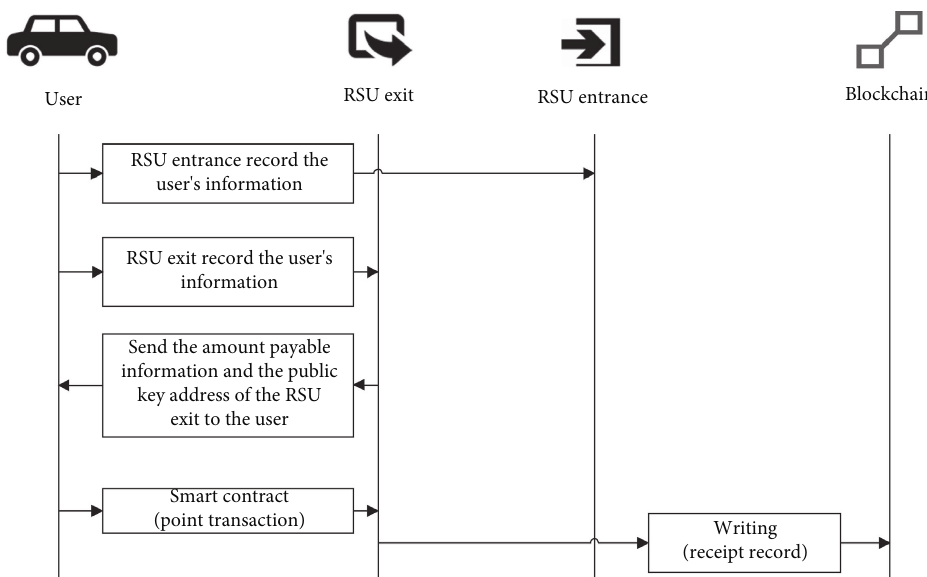
Figure 6: Point transaction between user and